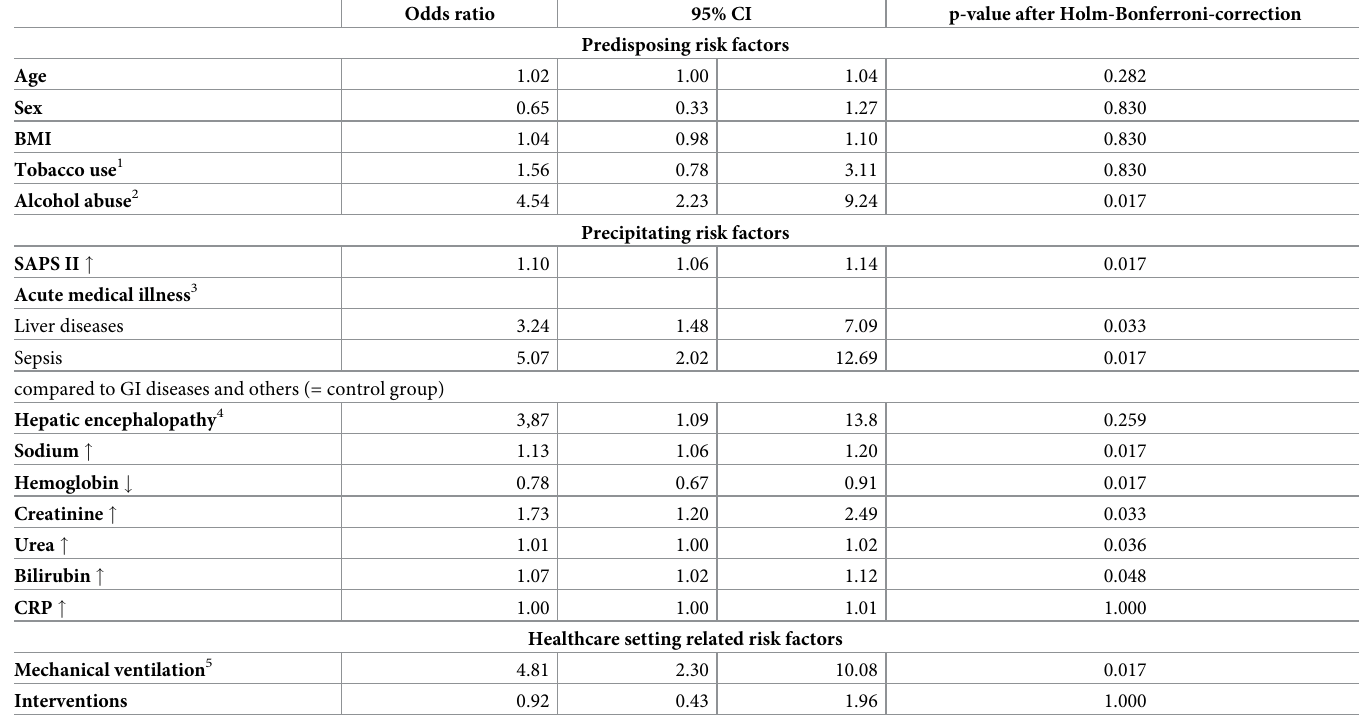
Table 4. Risk factors of delirium in an